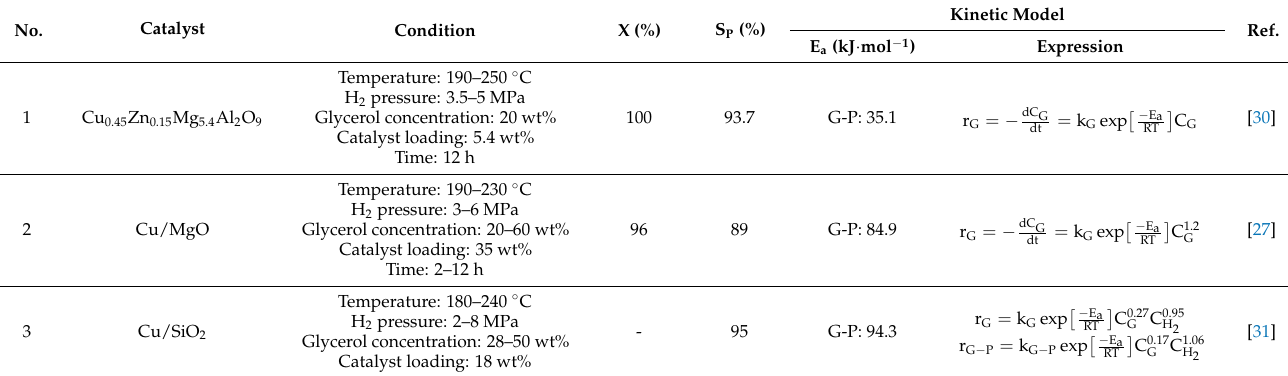
Table 2. Power law models for glycerol hydrogenolysis over Cu-based